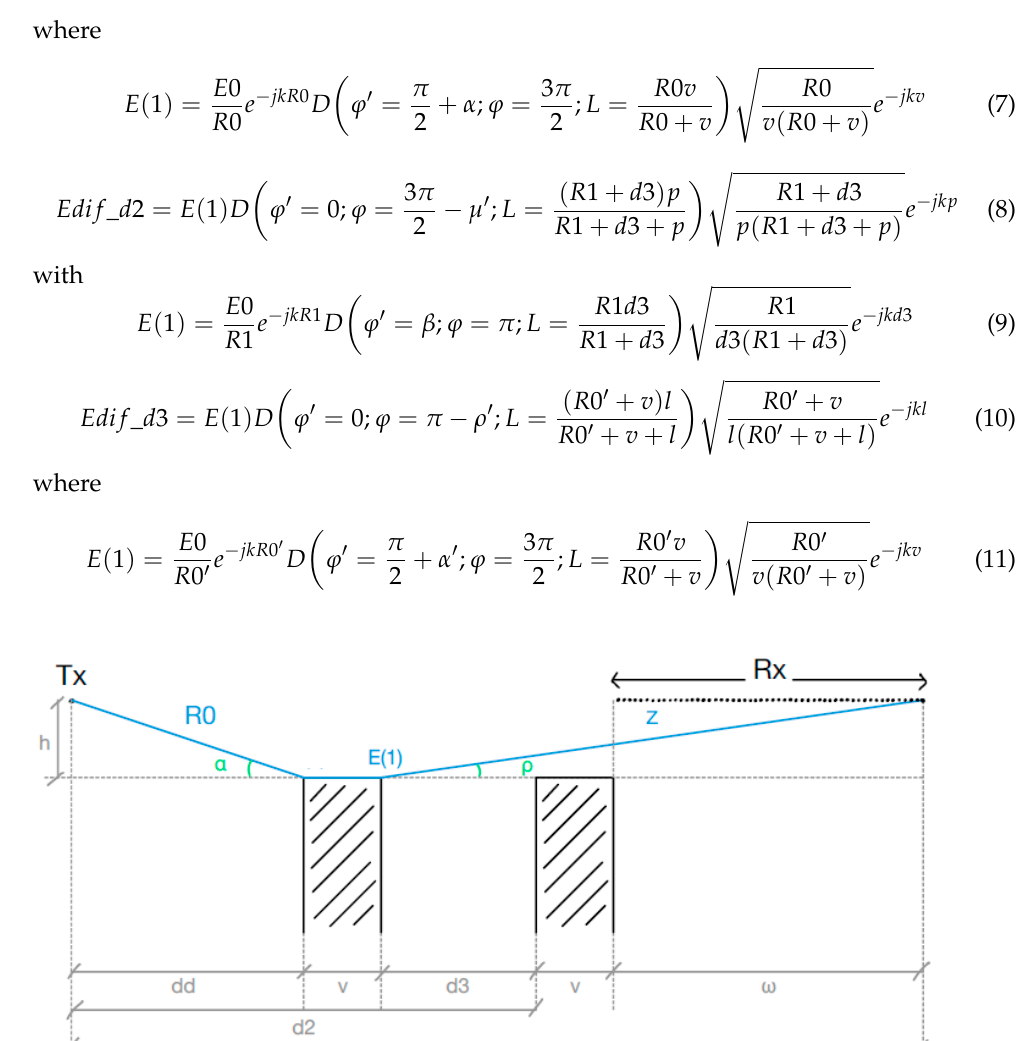
Figure 7. First double diffraction (Edif_d1) of the considered LOS scenario.